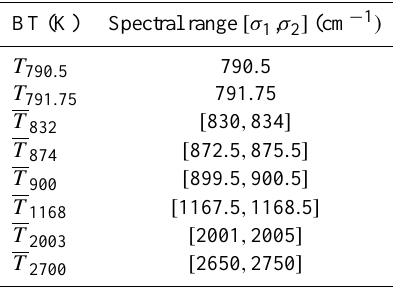
Table 2. Definition of the brightness temperatures involved in the